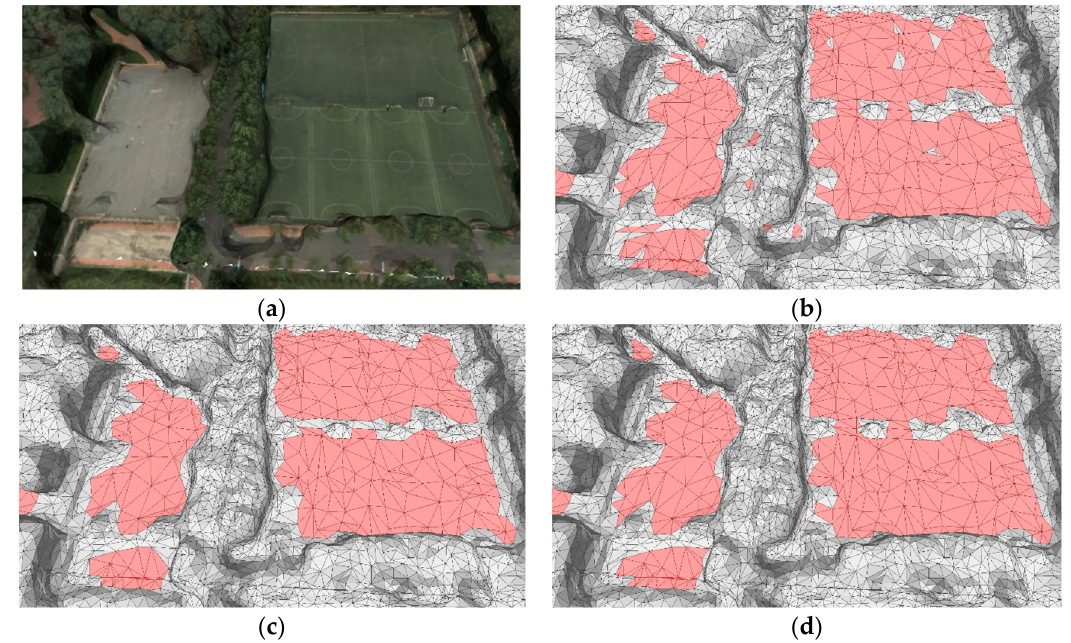
Figure 6. Different methods for detecting planar surfaces (in red). ( a ) Input 3D model with texture. ( b ) Recognition of planar surfaces according to the dihedral angles of edges. ( c ) The planarity of vertices without extension based on the threshold of dihedral angle. ( d ) The planarity of vertices with extension (our method). It is apparent that (d) better matches the continuity of the playground.